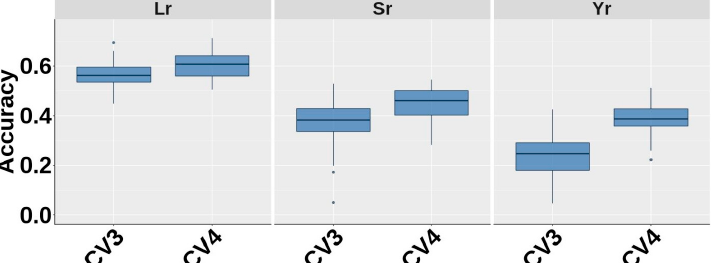
Figure 6. Prediction accuracies for bivariate analysis of adult plant resistance (APR), where APR was the target trait and all stage resistance (ASR), was the second trait. CV3: Phenotypes of accessions in validation set were removed entirely from reference population; CV4: respective phenotypes for validation accessions for the second trait were included in the reference population.